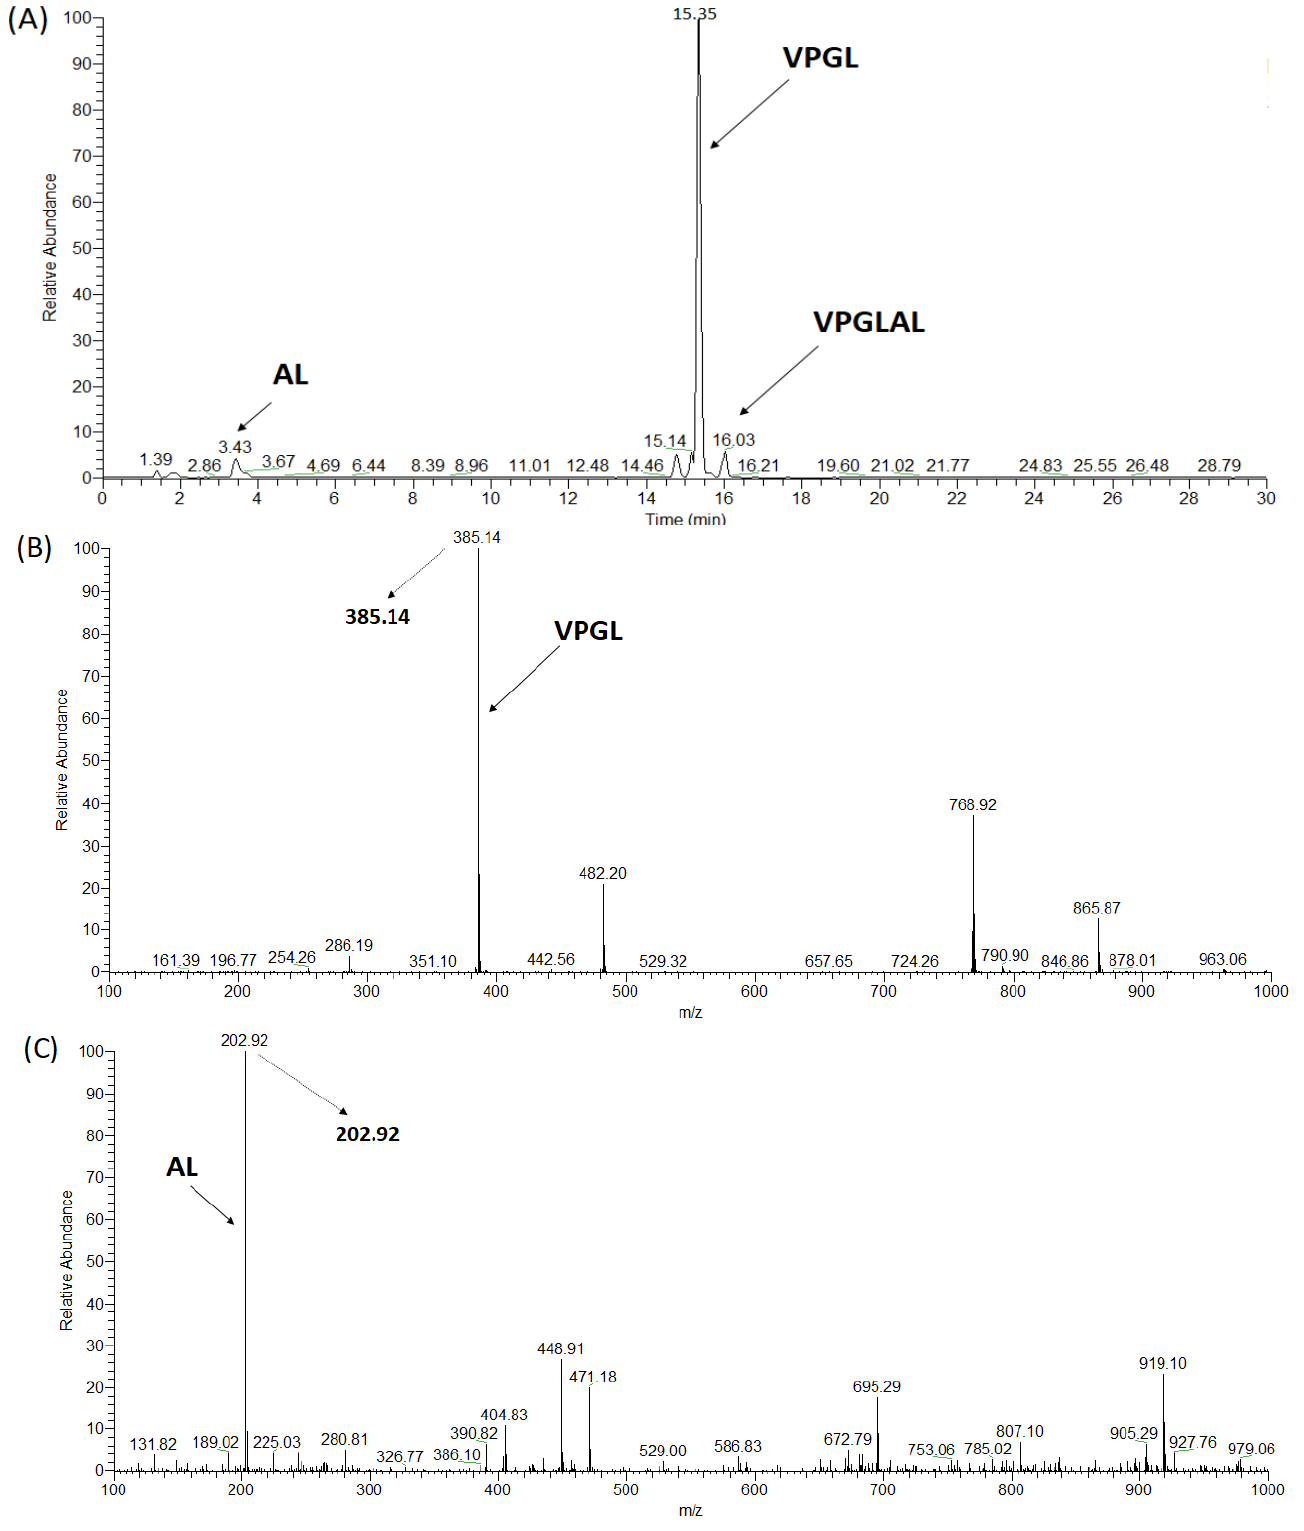
Figure A4. The stability of VPGLAL against the ACE activity under the pre ‐ incubation condition with ACE. ( A ) LC ‐ MS profile of VPGLAL. Two small fragments derived from VPGLAL after pre ‐ incubation with ACE include: ( B ) the MS spectrum of fragment VPGL (m/z 385.17), and ( C ) the MS spectrum of fragment AL (m/z 202.92).